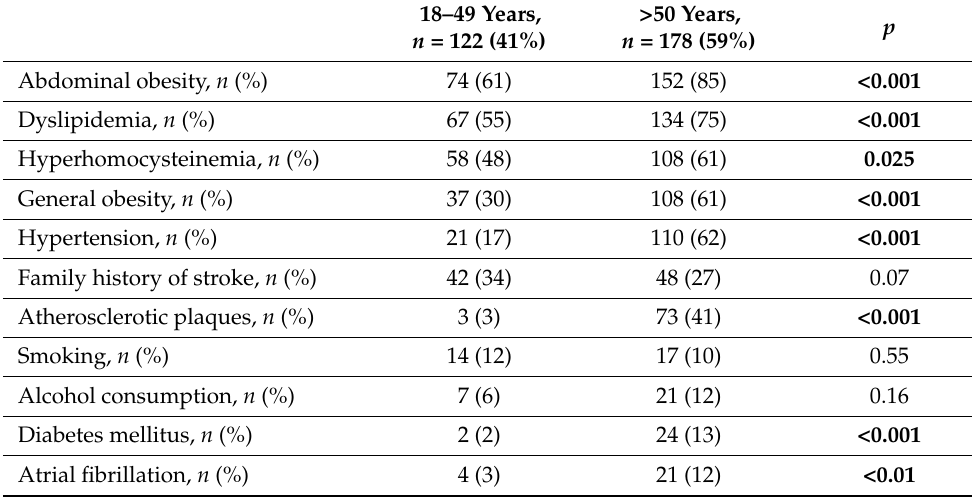
Figure 2. Scatter plots representing the correlations between age and systolic blood pressure (sBP) ( a ), diastolic blood pressure (dBP) ( b ), body mass index ( c ), waist circumference ( d ), blood uric acid levels ( e ), and intima – media thickness (IMT) ( f ). Table 2. Distribution of risk factors in age